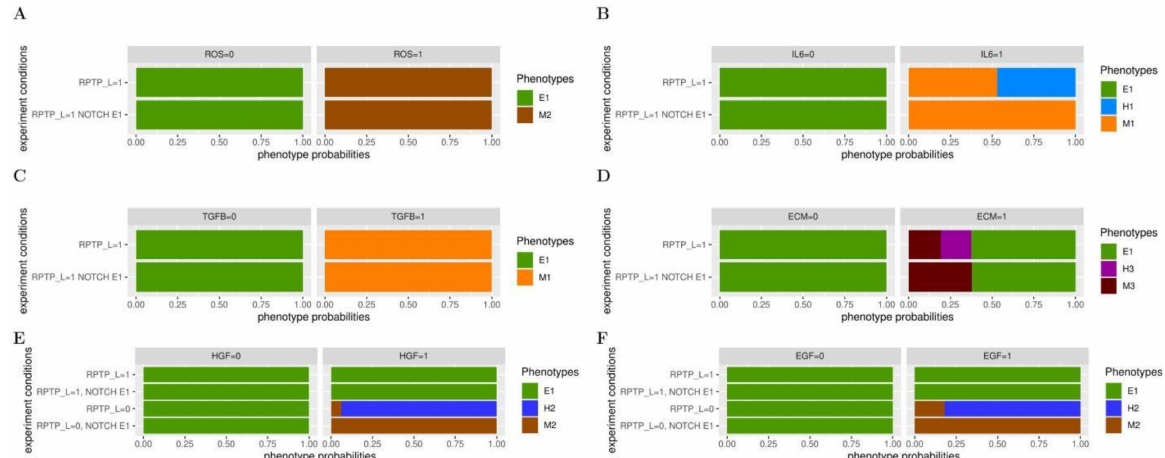
Figure 4. The EMT logical model predicts cooperation between a NOTCH GoF mutation and microenvironment signals. Probabilities of the reachable phenotypes, starting from an E1 phenotype, in the presence or absence of a NOTCH GoF mutation (NOTCH E1) when switching microenvironmental signals. ( A – D ) ROS ( A ) or IL6 ( B ) or TGFB ( C ) or ECM ( D ) is set up to 0 or 1, in the presence (=1) or absence (=0) of NOTCH E1. ( E , F ) HGF ( E ) or EGF ( F ) is set up to 0 or 1, in the presence (=1) or absence (=0) of NOTCH E1 and of RPTP_L. In each condition, inputs that are not indicated are fixed to